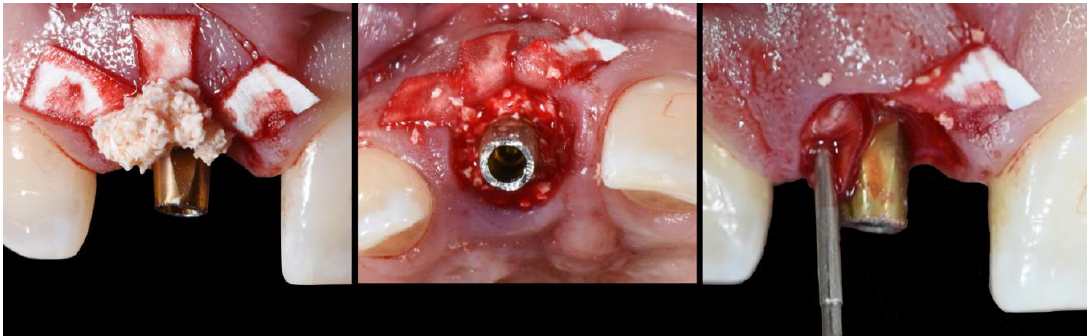
Figure 7. Slow absorbable bone substitute material is packed to fill the gap and membrane adaptation. Step 7.